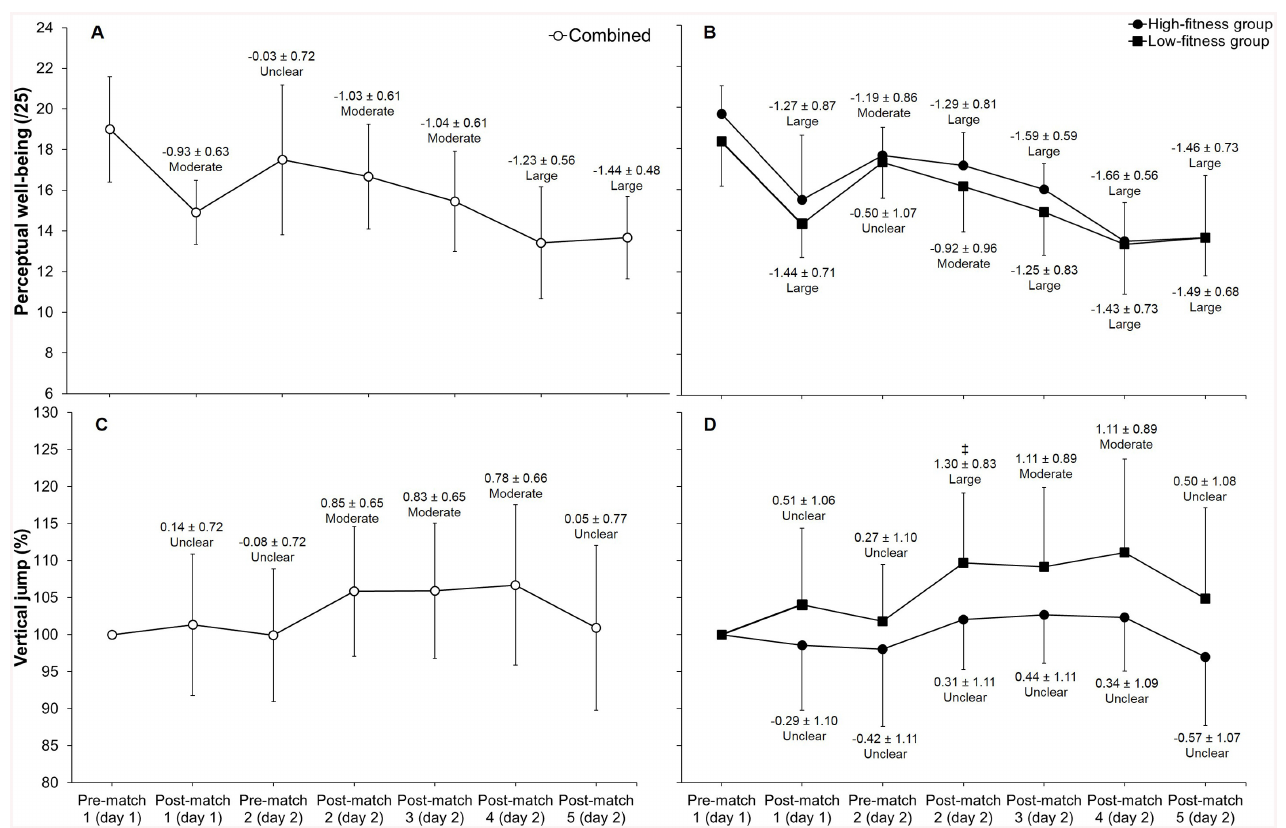
Fig 3. Changes in perceived well-being (A and B) and jump height (C and D) for tag football players grouped into high- and low-fitness groups during the tournament. ‡ indicates a moderate difference between low- and high-fitness